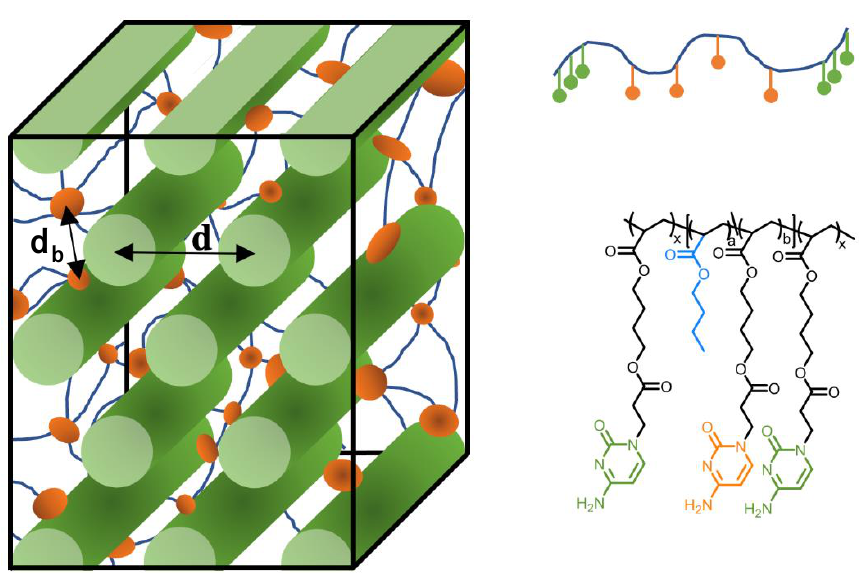
Figure 6. Schematic representation of the CyA triblock copolymer morphology based on